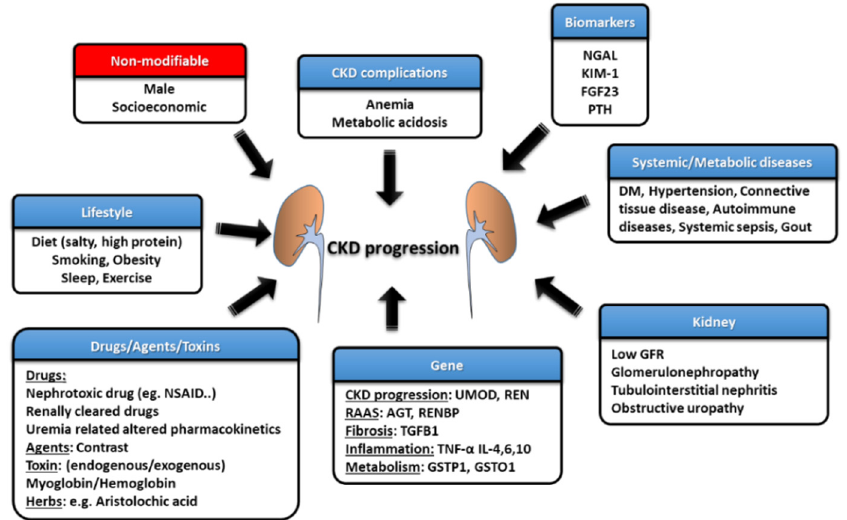
Figure 2. The risk factors and management strategies of CKD development and progression.